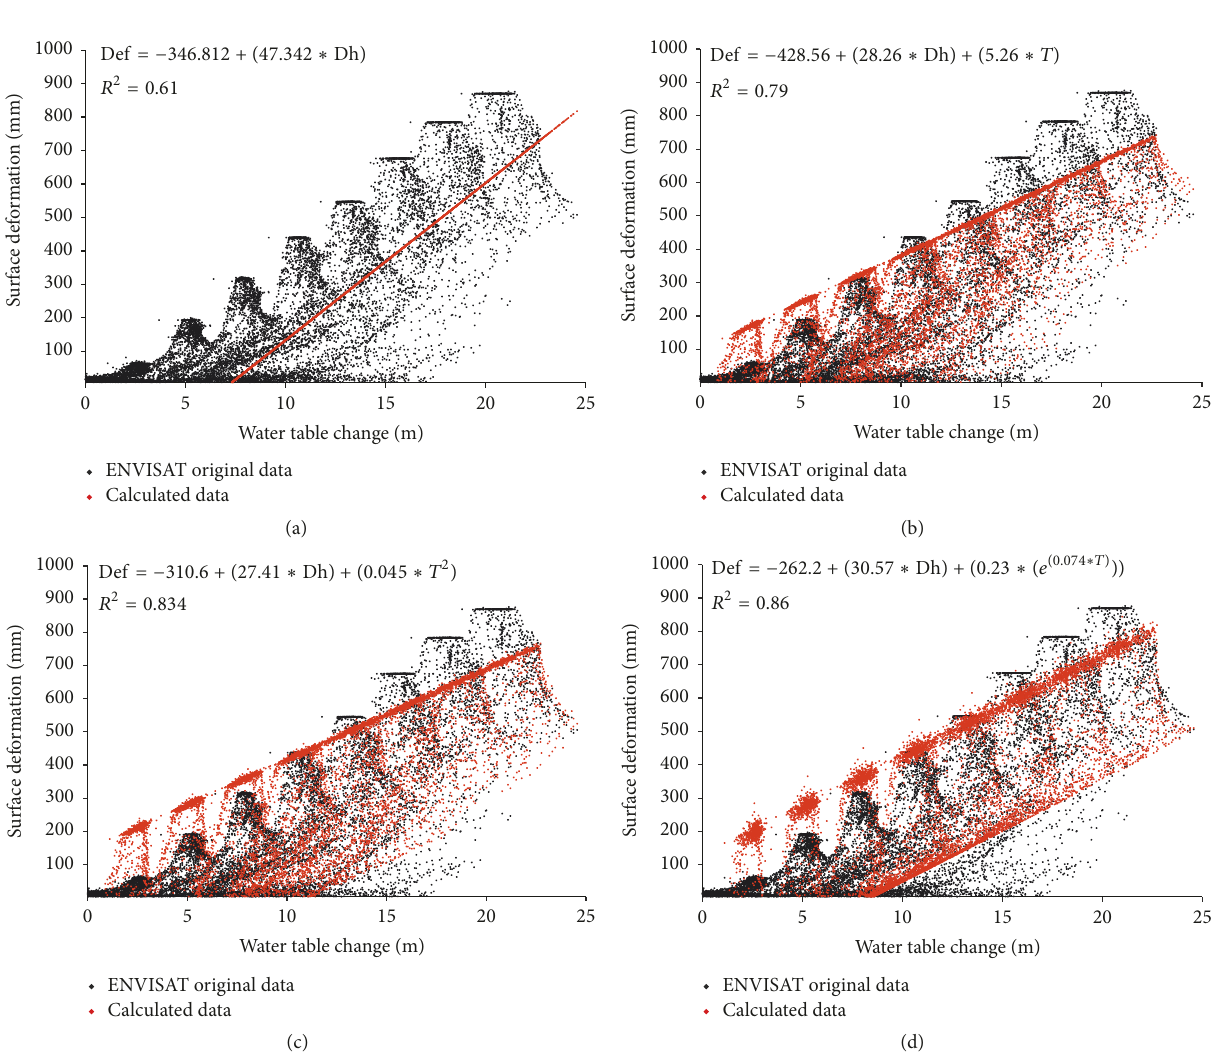
Figure 9: Deformation models adjustment. Def represents surface deformation, Dh is water change, and 𝑇 is the soft soils thickness. (a) Adjustment with a lineal term for water changes ( 𝑟 2 = 0.61). (b) Adjustment with a lineal term for water changes plus a lineal term for soft soil thickness ( 𝑟 2 = 0.79). (c) Adjustment with a lineal term for water changes plus a quadratic term for soft soil thickness ( 𝑟 2 = 0.834). (d) Adjustment with a lineal term for water changes plus an exponential term for soft soil thickness ( 𝑟 2 =